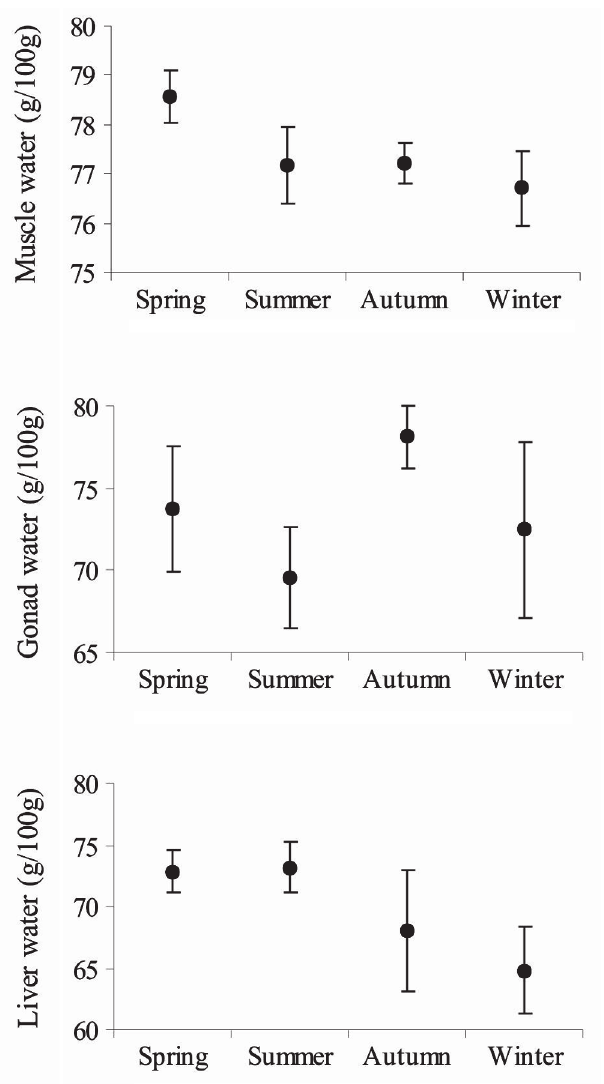
Fig. 4. Seasonal variation of water content (moisture) in muscle, gonad and liver of Percophis brasiliensis